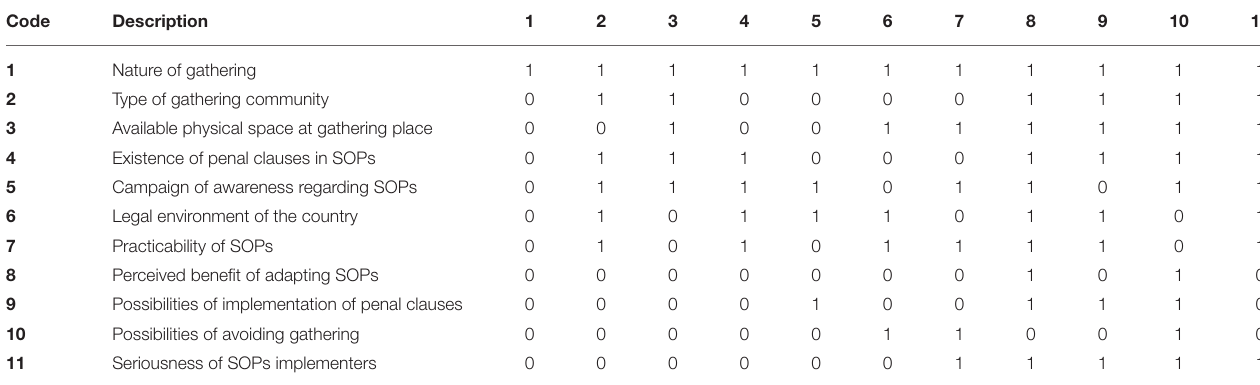
TABLE 4 | Initial reachability matrix.